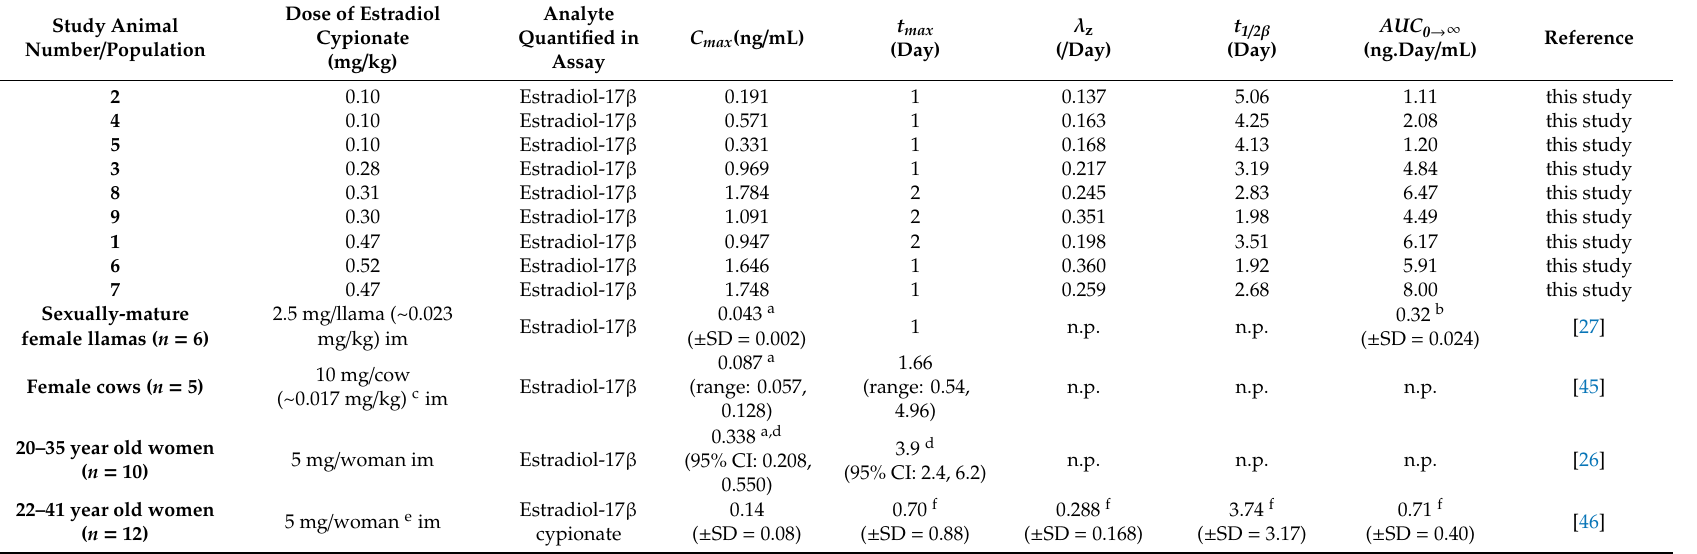
Table 1. Pharmacokinetic parameters of estradiol-17 β in feral cats and other